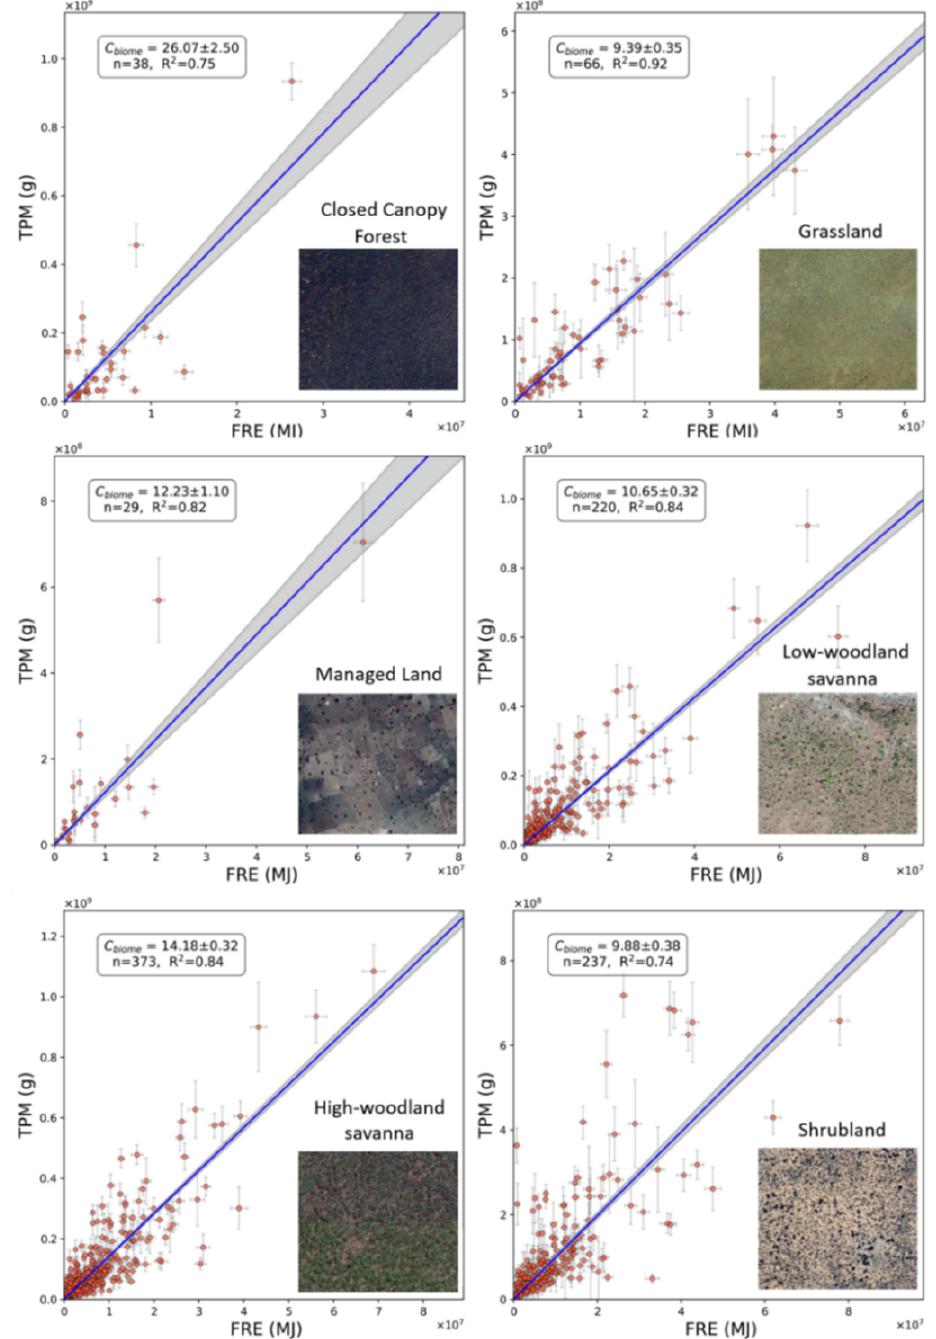
Figure B1. TPM smoke emission coefficients (C TPM e ; in gMJ − 1 ) for the six African fire-affected biomes defined in the main text, each derived from the slope of an ordinary least-squares (OLS) regression between data of fire-emitted total particulate matter (TPM) and matching fire radiative energy (FRE). The grey shaded area defines the 95% probability prediction interval of the OLS-derived slope. Each scatter plot is accompanied by an illustrative insert that depicts the typical land cover for the biome as seen in © Google Earth (example locations are closed-canopy forest 10.359 ◦ S, 19.086 ◦ E; grassland 21.180 ◦ S, 19.560 ◦ E; managed land 10.495 ◦ N, 7.586 ◦ E; low-woodland savanna 7.085 ◦ N, 27.095 ◦ E; high-woodland savanna 12.523 ◦ S, 23.323 ◦ E; and shrubland 23.055 ◦ N, 22.242 ◦